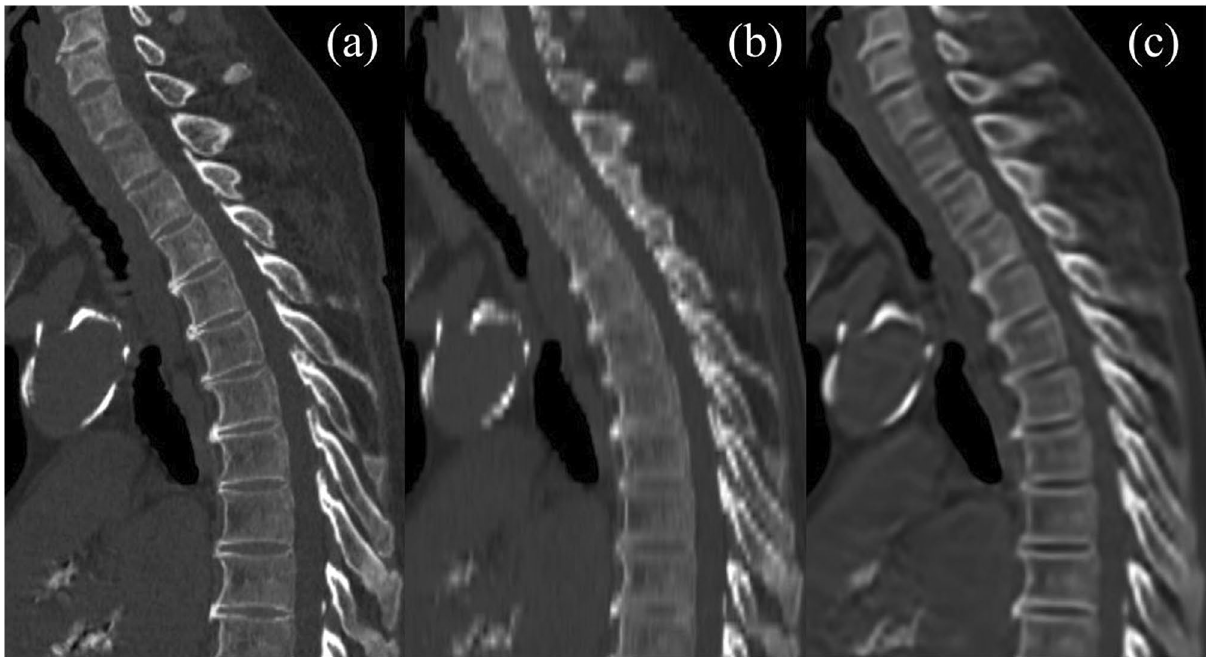
Figure 2. Sagittal reformatted images reconstructed from 1-mm-thick images ( a ), 4-mm-thick images ( b ), and virtual thin-slice images ( c ). The intervertebral spaces of the cervical and upper thoracic spine are not clearly depicted on the reconstruction from 4-mm-thick images. On the reconstruction of virtual thin-slice images, the intervertebral spaces are more clearly depicted and it is easier to recognize the shapes of the vertebral